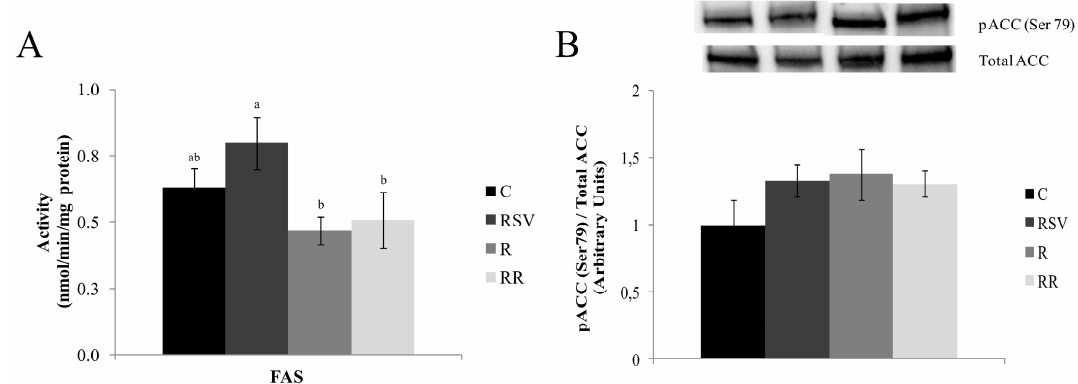
Figure 1. FAS activity ( A ) and phosphorylated ACC (serine 79)/Total ACC ratio ( B ) in liver from rats fed an obesogenic diet for six weeks, and then fed a standard diet (C), or a standard diet supplemented with resveratrol (RSV), or submitted to energy restriction and fed a standard diet (R) or submitted to energy restriction and fed a standard diet supplemented with resveratrol (RR) ( n = 9/group) for additional six weeks. Values are mean ± SEM. Differences among groups were determined by using one-way ANOVA followed by Newman Keuls post-hoc test. Values not sharing a common letter are significantly different ( p < 0.05). FAS: fatty acid synthase, ACC: acetyl CoA